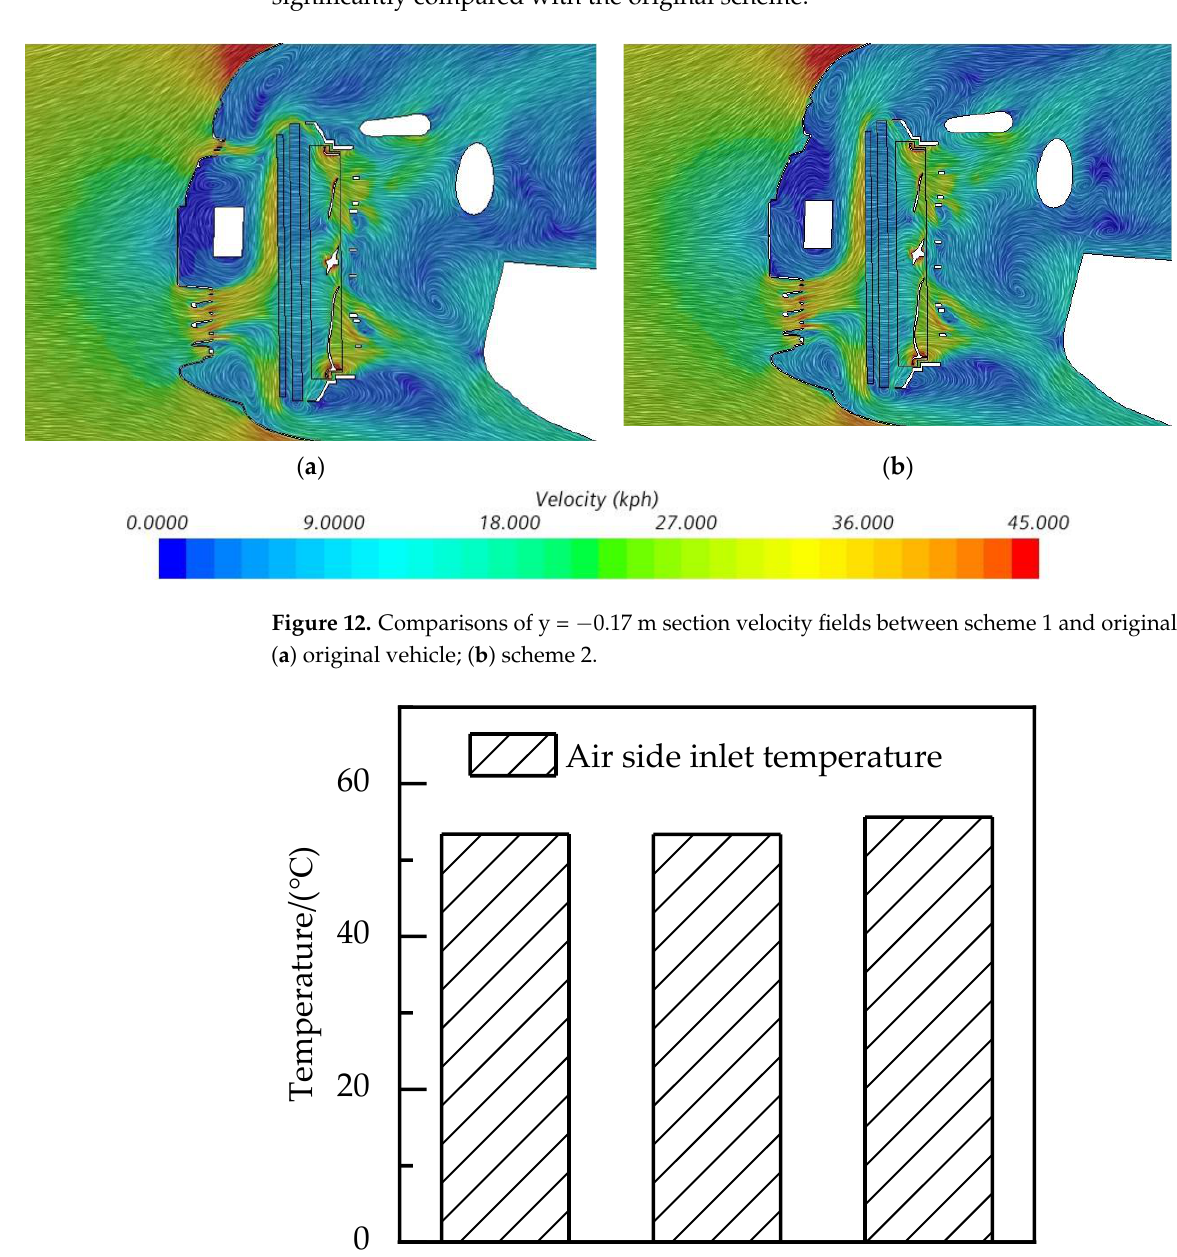
Figure 11. Comparisons of z = 0.44 m section pressure nephogram between scheme 1 and original vehicle: ( a ) original vehicle; ( b ) scheme 1.